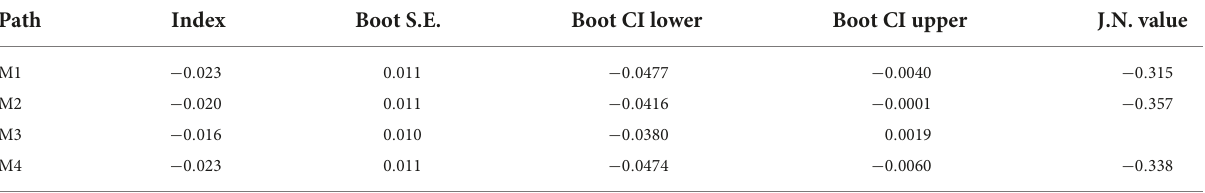
TABLE 5 Index of parental support’s moderated mediation on four sub-dimensions ( N =